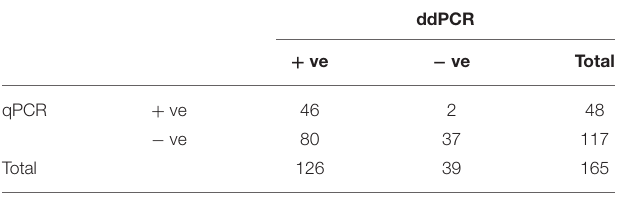
OaPVDNAwasdetectedin126bloodsamples.qPCRrevealedOaPVDNAin48samples, 46 of which were also positive to ddPCR. Both methods failed to detect any OaPV DNA in 39 blood samples.